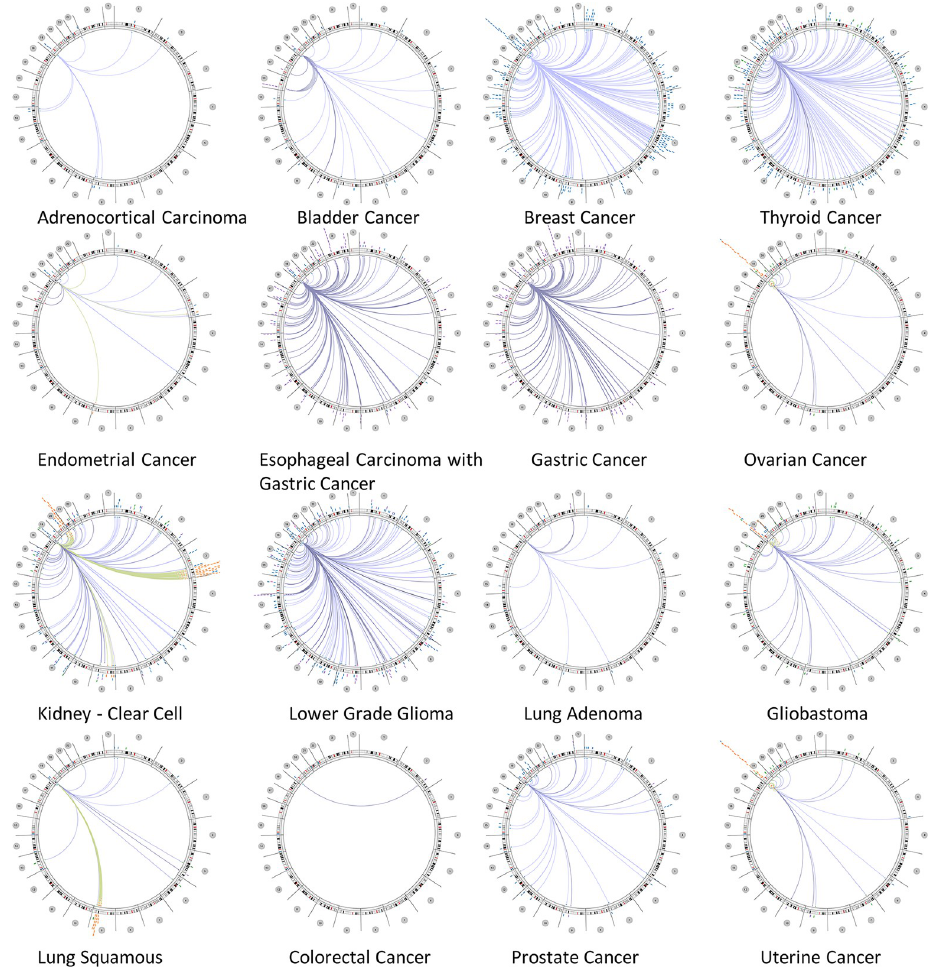
Fig 6. Circus diagram showing the correlation between CALR and other genes from the TCGA